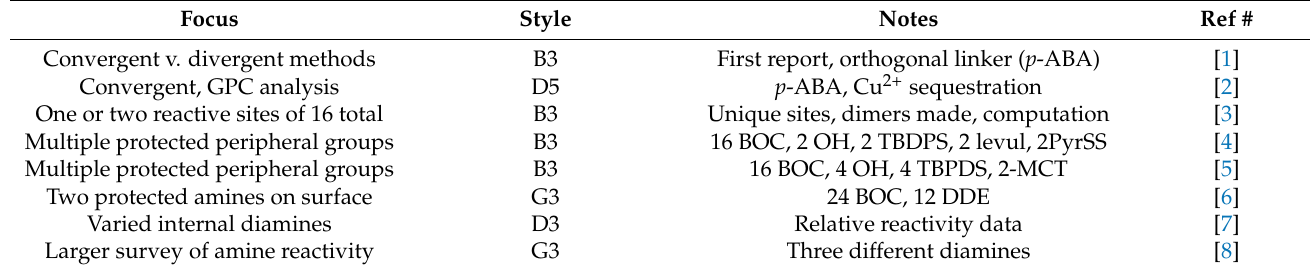
Table 1. Synthetic efforts utilizing the convergent strategy. ‘B’ refers to a two-branched bowtie dendrimer, ‘G’ refers to a three-branched dendrimer, ‘D’ refers to a dendron with a reactive focal point. The number following these letters corresponds to the generation. p- ABA is p- aminobenzlamine, common protecting groups incorporated on the surface include BOC, TBDPS, pyridyl disulfides (PyrSS), levulinic amides (levul), or DDE groups. MCT is monochlorotriazine. OH indicates free hydroxyls.